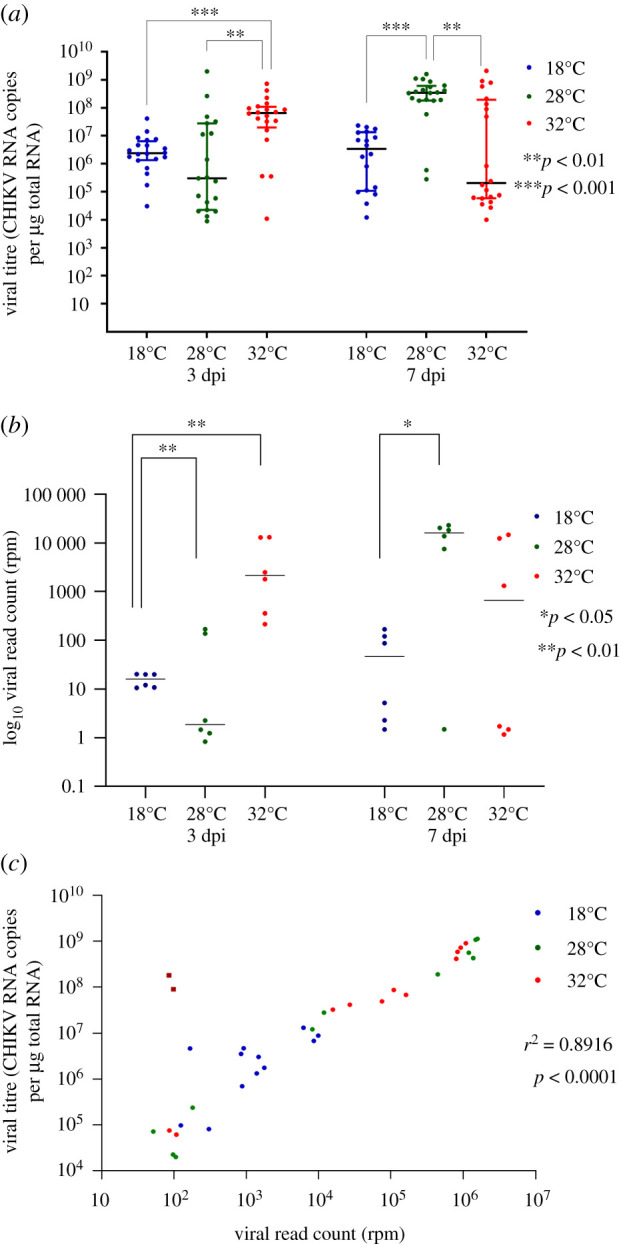
Effect of temperature and day post infection (dpi) on CHIKV replication in Ae. aegypti mosquitoes. (a) CHIKV RNA copy numbers detected using qRT-PCR in whole mosquito bodies, 18°C (n = 20 and n = 18), 28°C (n = 19 and n = 20) and 32°C (n = 20 in each time point), sampled at 3 and 7 dpi. Statistical significance was assessed using Mann–Whitney tests. (b) CHIKV read counts obtained from RNAseq of Ae. aegypti samples (six mosquito bodies per each temperature/dpi combination). Log10 normalized reads per million (RPM) counts shown. (c) Pearson correlation between body CHIKV titre from qRT-PCR and virus read counts, across all temperatures and both time points. Each point on the plots represents an individual mosquito. The dark blue squares in (c) indicate two outlier samples that were removed from downstream analyses of the mosquito transcriptome.